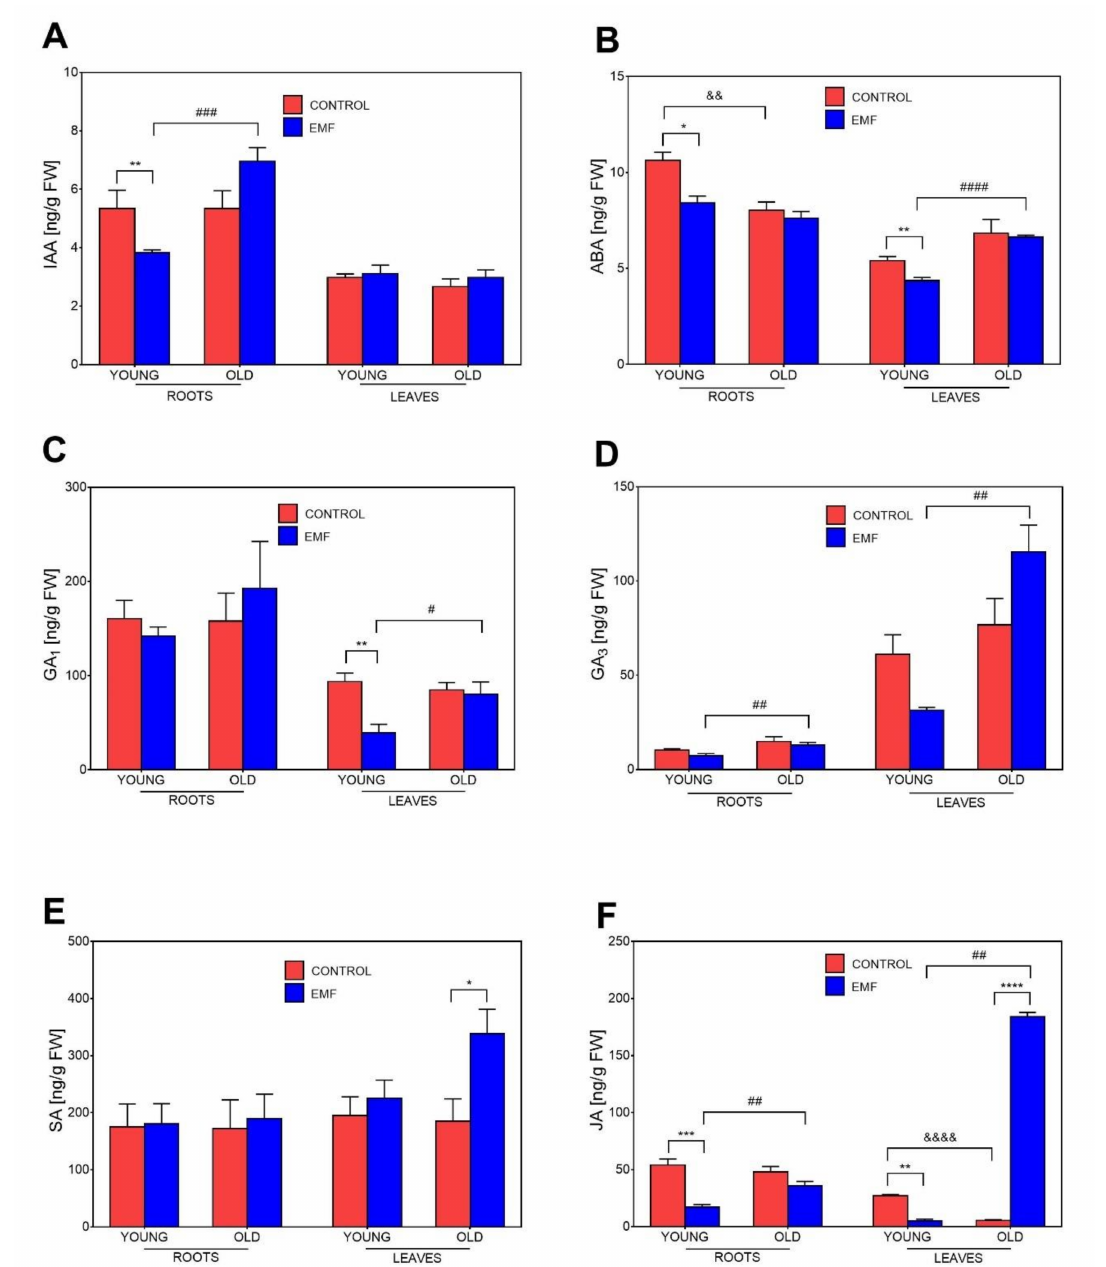
Figure 6. The amount of IAA ( A ), ABA ( B ), GA 1 ( C ), GA 3 ( D ), SA ( E ) and JA ( F ) phytohormones in roots and leaves of two-week-old plants of field bean growing in pots from young and old seeds treated with EMF, and their controls. Data are the means ± SE ( n = 3). The symbol (*) indicates significant differences between EMF-treated and control groups (* p < 0.05, ** p < 0.01, *** p < 0.001, **** p < 0.0001); “&” indicates significant differences between control groups ( && p < 0.01, &&&& p < 0.0001); “#” indicates significant differences between EMF-treated groups ( # p < 0.05, ## p < 0.01, ### p < 0.001, #### p <